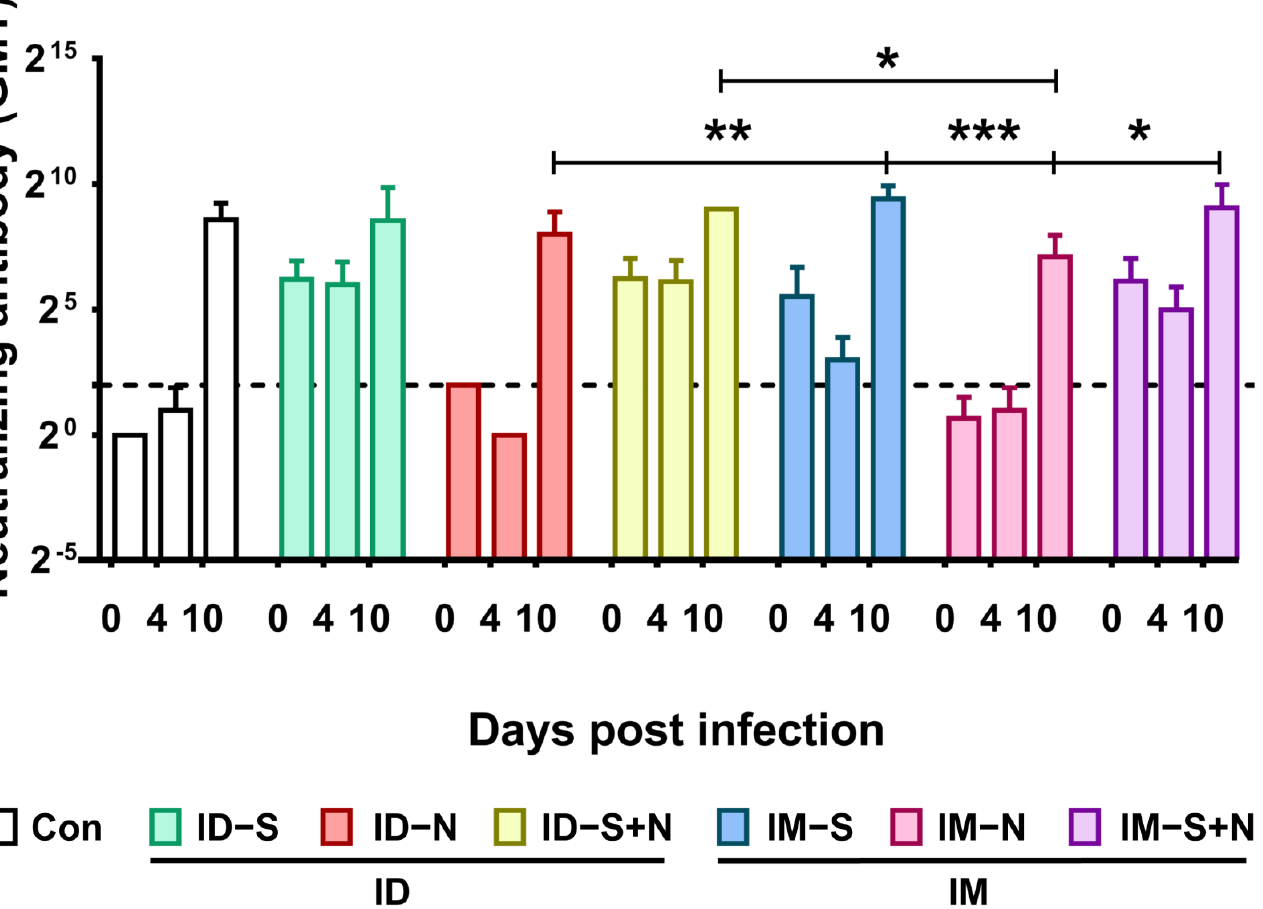
Figure 8. Neutralizing antibody levels in hamsters during viral challenge after immunization with recombinant proteins via the ID and IM routes. The titers of neutralizing antibodies were detected at 0 (14 days after the booster), 4, and 10 days after viral challenge. The dotted line in the neutralizing antibody graph represents the positive threshold (neutralizing antibody titer of 4). The differences between the immunized groups and the control group were analyzed by two-way ANOVA. *, p < 0.05; **, p < 0.01; ***, p < 0.001 ( n = 10 per group (14 days after the booster or 0 days after viral challenge) and n = 3 (4 and 10 days after viral challenge) for each time point).